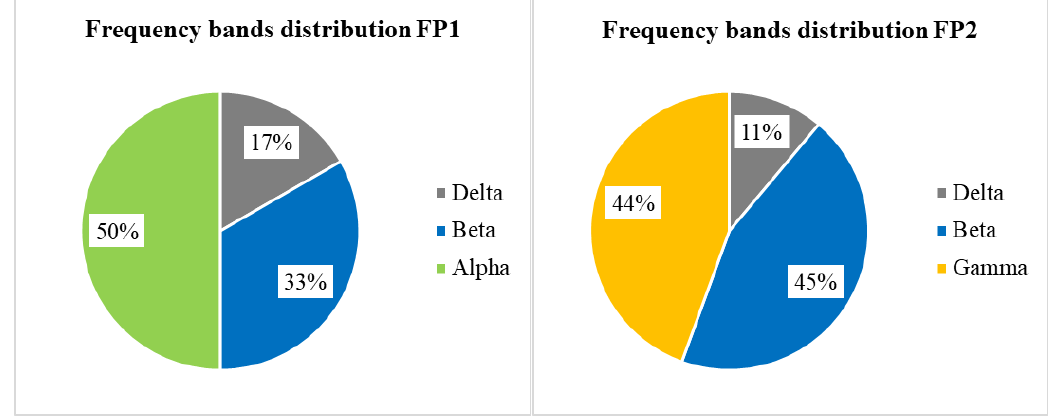
Figure 7. Distributions of EEG features by frequency bands for each